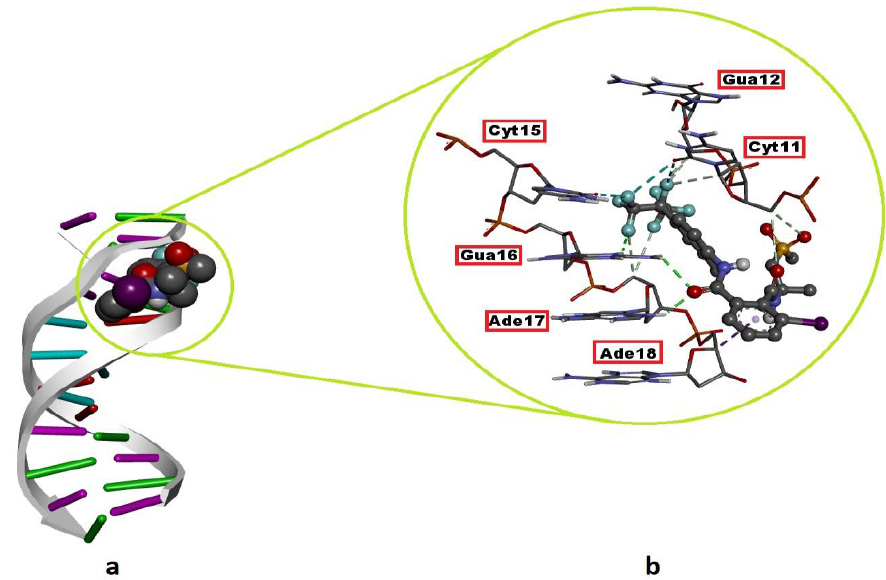
Figure 9. Top-ranked conformation of the intermolecular interaction between flubendiamide and B-DNA. ( a ) Cartoon view of the DNA–flubendiamide complex; ( b ) 3D DNA-ligand interaction diagram of the top-ranked docking conformation. Nucleotides in interaction with flubendiamide are outlined in red boxes. The green and light grey dashed lines on the right image represent hydrogen bonds, whereas the purple and light cyan dashed lines represent the hydrophobic contact and halogen (fluorine) interactions, respectively.